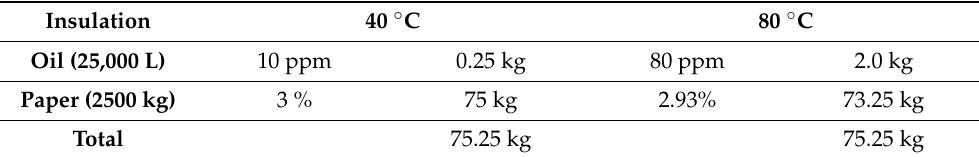
Table 12. Water distribution in a 25 MVA transformer for different